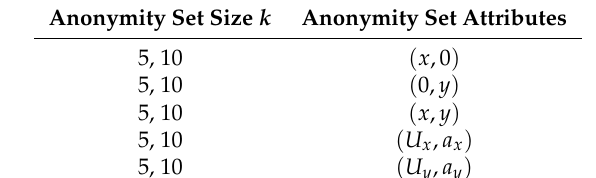
Table 11. Parameters when using N = 500 Trajectories, L = 100 Timestamps. Anonymity Set Size k